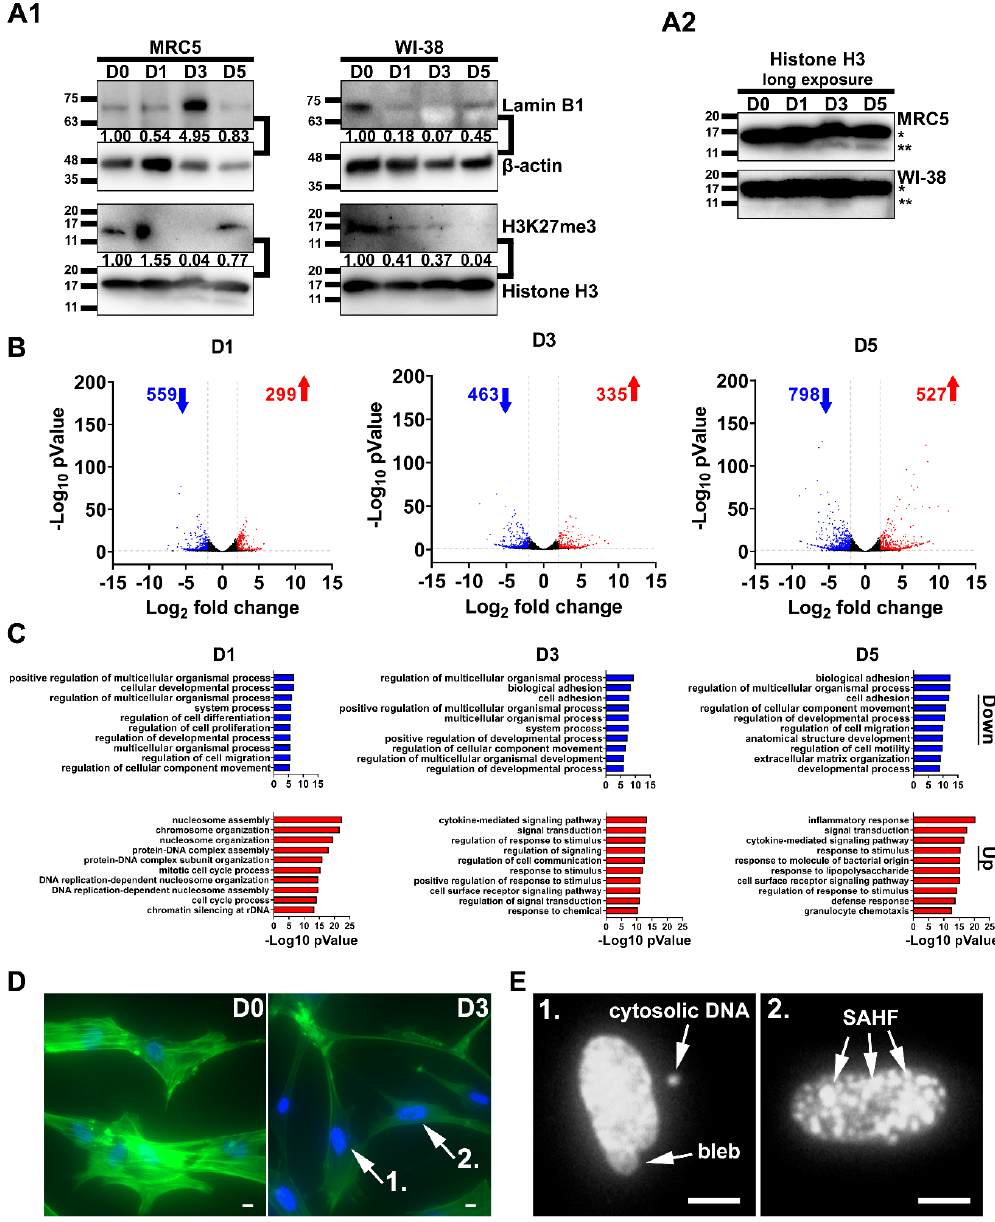
Figure 3. Dynamic chromatin remodeling and gene expression in SCM-induced senescence. ( A1 ) Western blot showing the variation in lamin B1 and H3K27me3 levels in MRC5 and WI-38 cells over a five-day time course. The number below each band is the densitometry value (intensity ratio) compared to β -actin or histone H3 and relative to the control condition. ( A2 ) Long exposure of Histone H3 loading control (* full-length Histone H3, ** cleaved). ( B ) Time course RNA-sequencing of MRC5 cells undergoing SCM-induced senescence. Volcano plots show differential gene expression between control (D0) and SCM-treated samples (D1, D3, and D5). The sequencing of RNA was performed in triplicate for each time point. The number of genes up- (red) and down-regulated (blue) are labeled on each plot. ( C ) GO enrichment analysis of transcriptome data. The up- (red) and down-regulated (blue) genes in the plots in B were all used in the analysis. The graphs show the top-10 biological processes affected by SCM conditions at each time point. ( D ) MRC5 cells stained for the nucleus (blue) and F-actin (green) at D0 and D3 (Scale Bar, 10 µ m). ( E ) Nuclei labeled 1 and 2 from D are enlarged and presented in greyscale to show nuclear blebbing, cytosolic DNA, and SAHF (Scale Bar, 10 µ